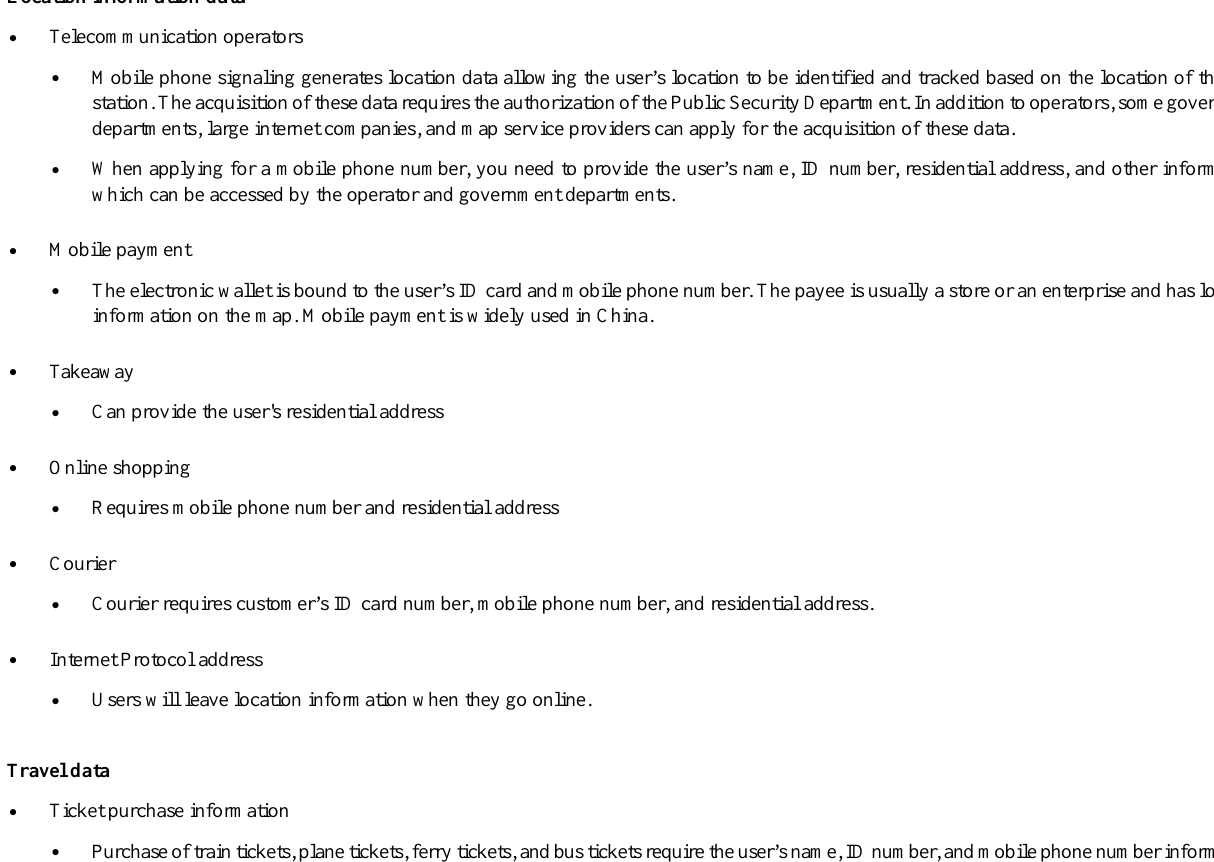
papers, public reports, institutional reports, and